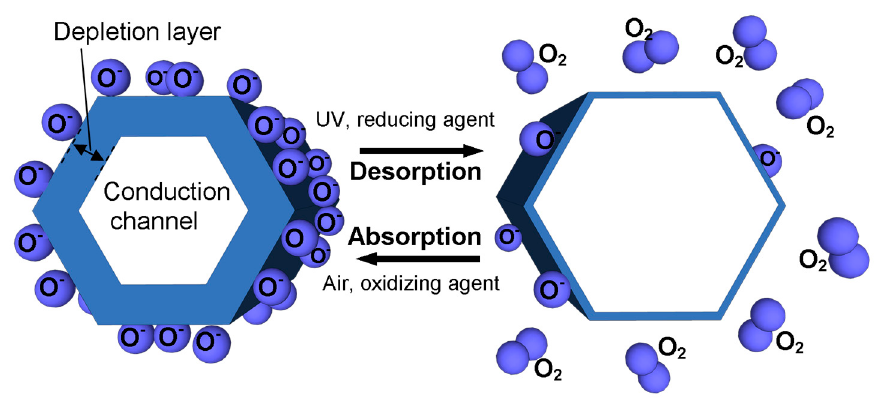
Figure 1. Schematics of unified ZnO nanowire (NW) chemoresistive sensing principle, based on the depletion layer width change with absorption-desorption of oxygen.